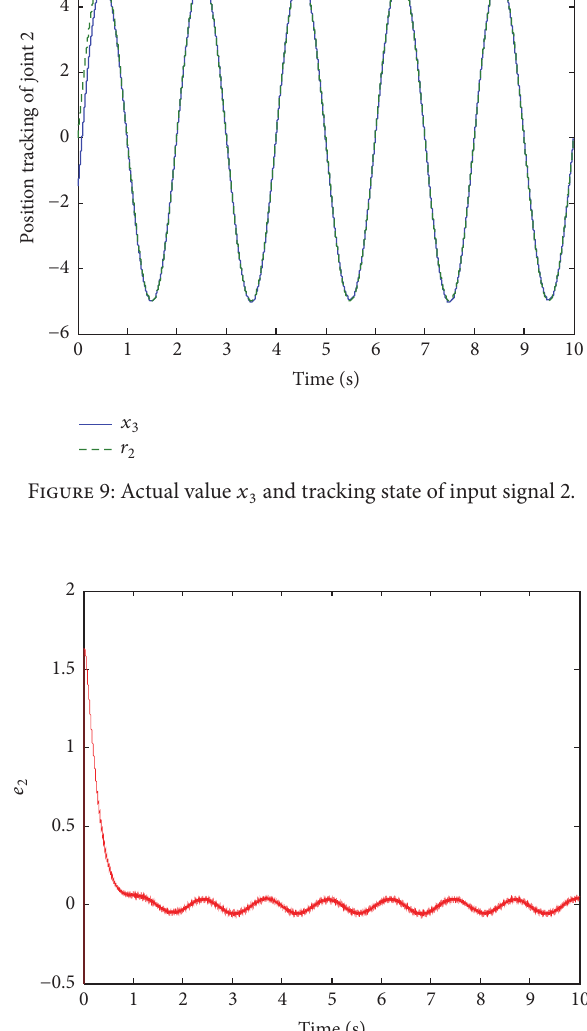
Figure 7: Actual value 𝑥 1 and tracking state of input signal 1.